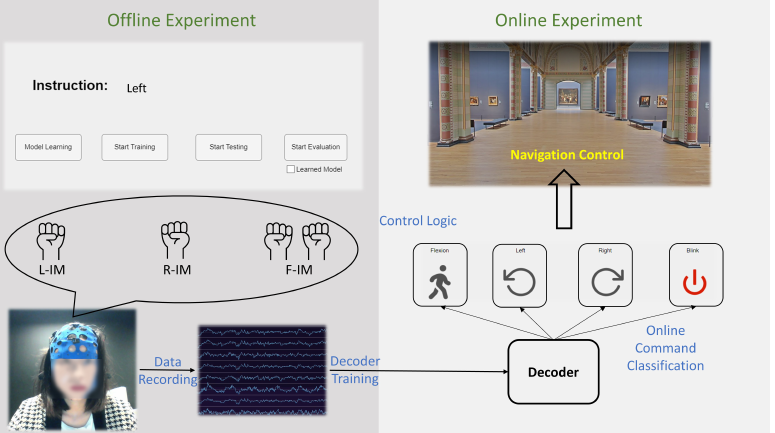
Figure 1. System Overview: left panel: offline training session, right panel: online real time naviga- tion control. L-IM stands for the left-hand imagined motor task, R-IM for the right-hand imagined motor task, F-IM for the flexion imagined motor task. See text for explanation. (The participant has given the consent to use her blurred